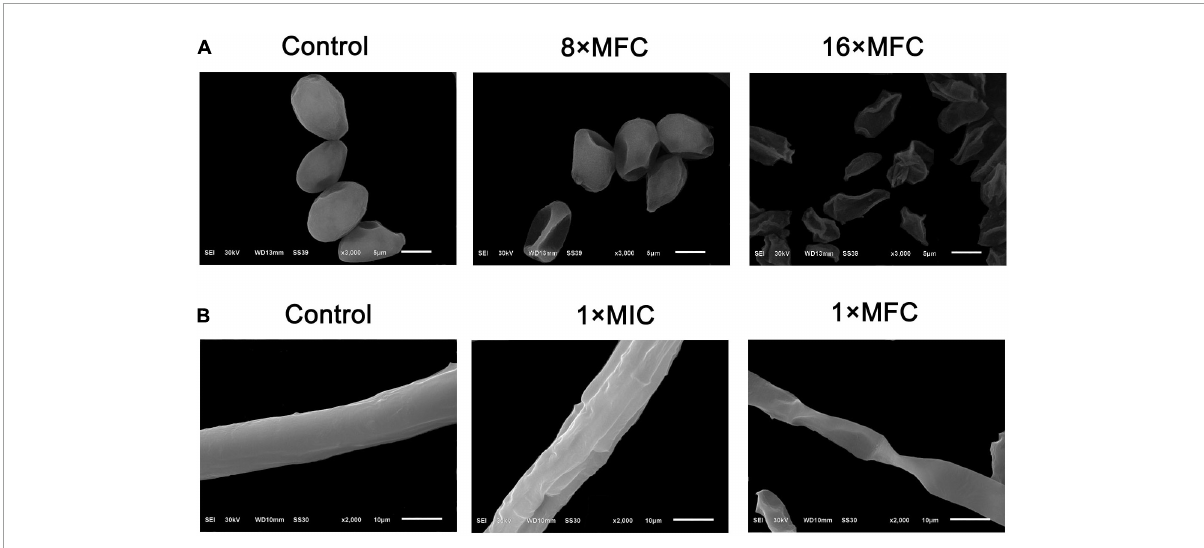
FIGURE2 Scanning electron microphotography of B. cinerea spores and hyphae after treatment with ( E )-2-hexenal. (A) Spores of untreated, 8 × MFC, and 16 × MFC ( E )-2-hexenal; (B) Mycelia of untreated, 1 × MIC (160 µ L/L), and 1 × MFC (320 µ L/L) ( E